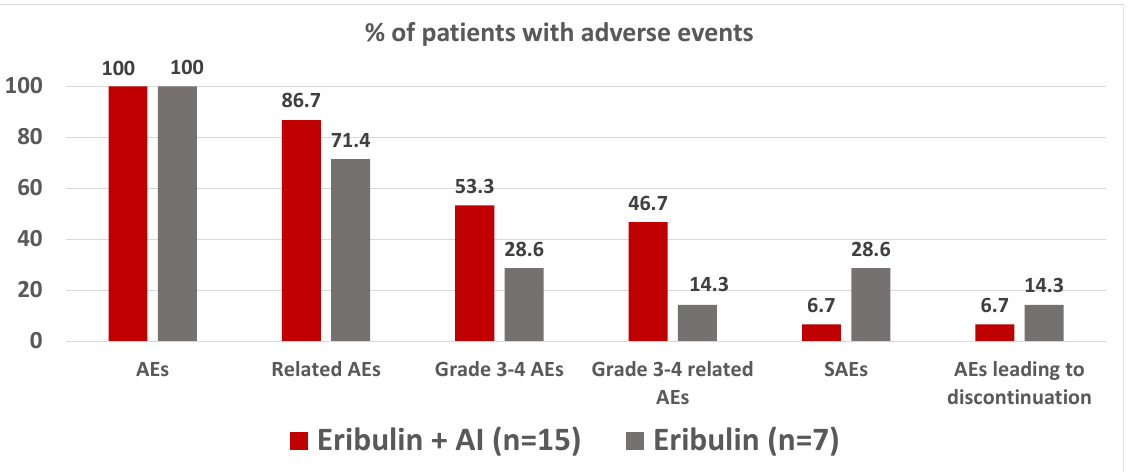
Figure 4. Summary of adverse events. AEs, Adverse events; AI, Aromatase inhibitor; SAEs, Serious adverse events.